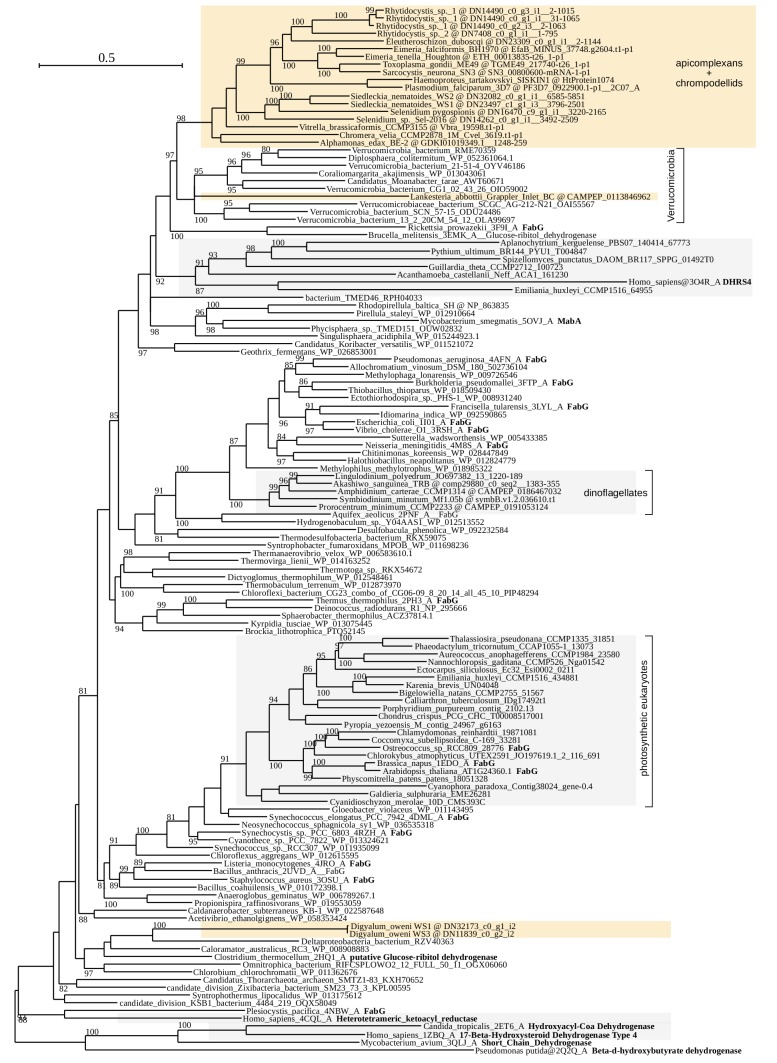
Maximum likelihood phylogeny of the beta-ketoacyl-acyl carrier protein reductase, FabG (LG+R6 model in IQ-TREE with 10000 UFBoot2 replicates;≥80 are shown).Apicomplexans, chrompodellids and Digyalum are shown on orange background and other eukaryotes on gray background. Selected characterized enzymes are highlighted in bold.